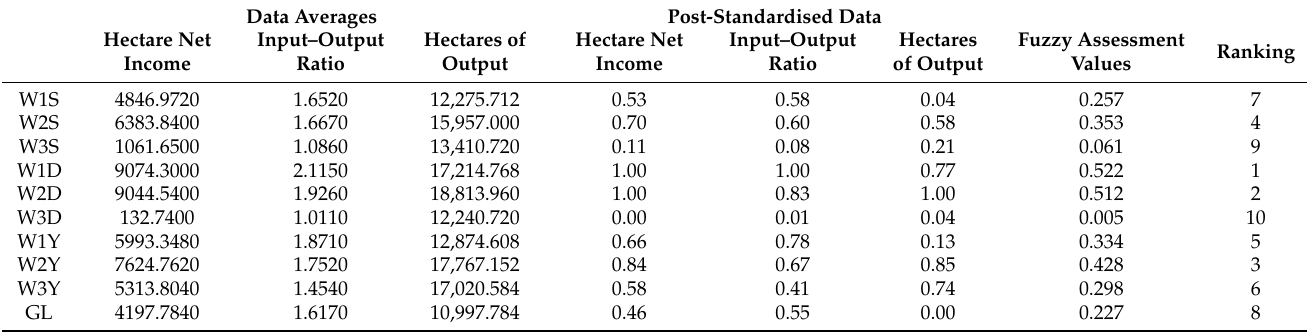
Table 6. Economic efficiency evaluation results and